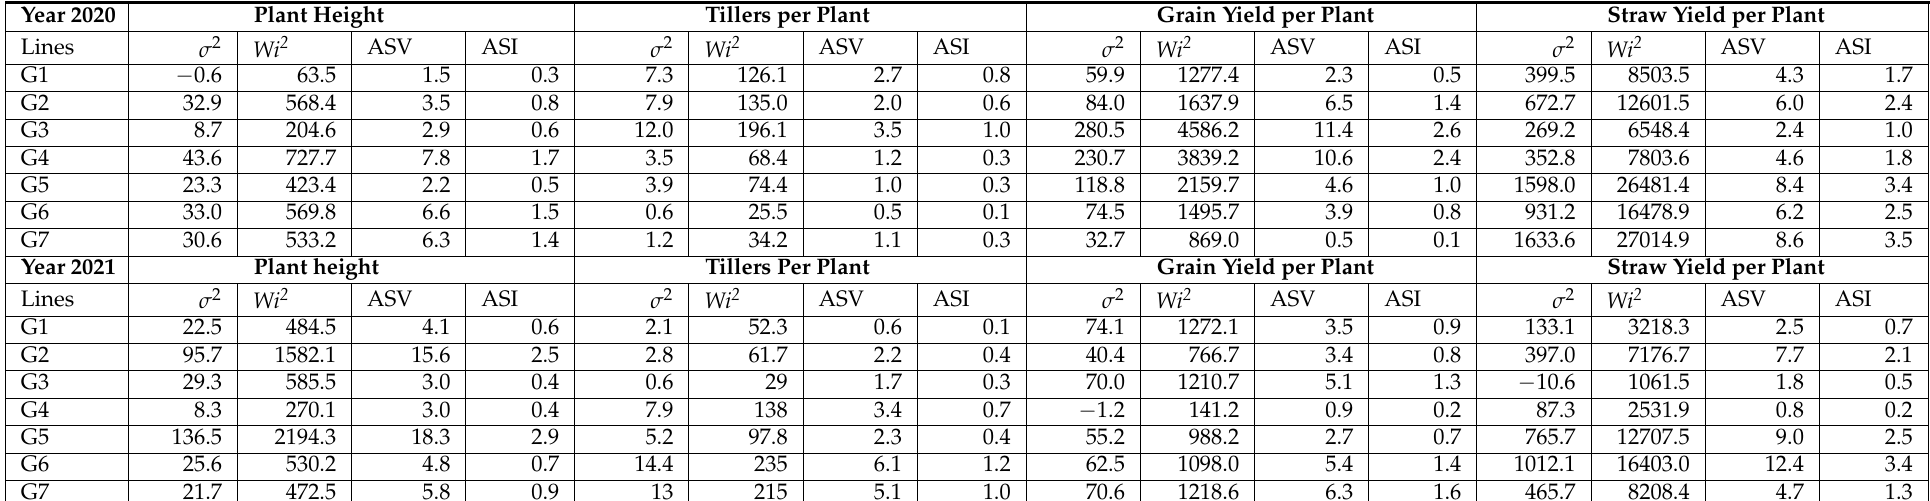
Table 5. Parametric stability statistics for Plant height, Tillers per plant, Grain yield per plant, and Straw yield per plant of seven rice genotypes grown in eight different locations in